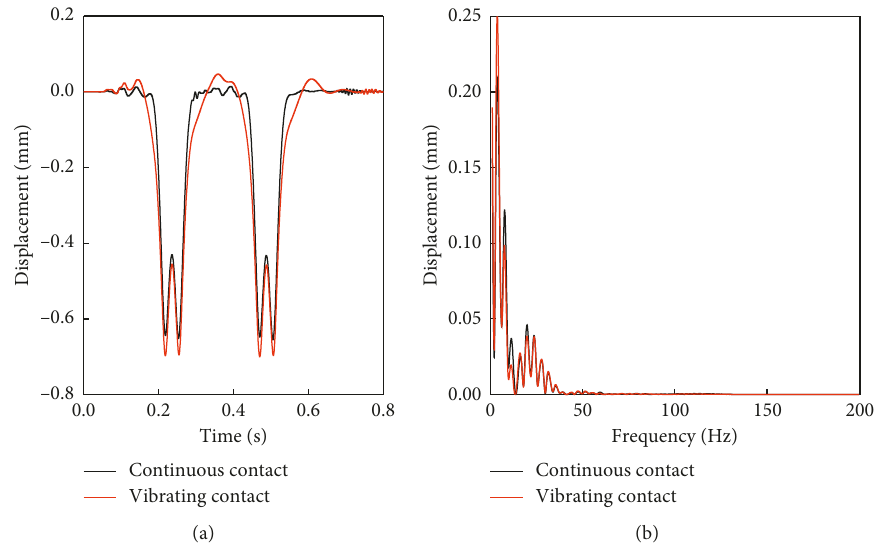
Figure 7: Dynamic displacements of rail in the states of continuous contact and vibrating contact: (a) time domain and (b) frequency